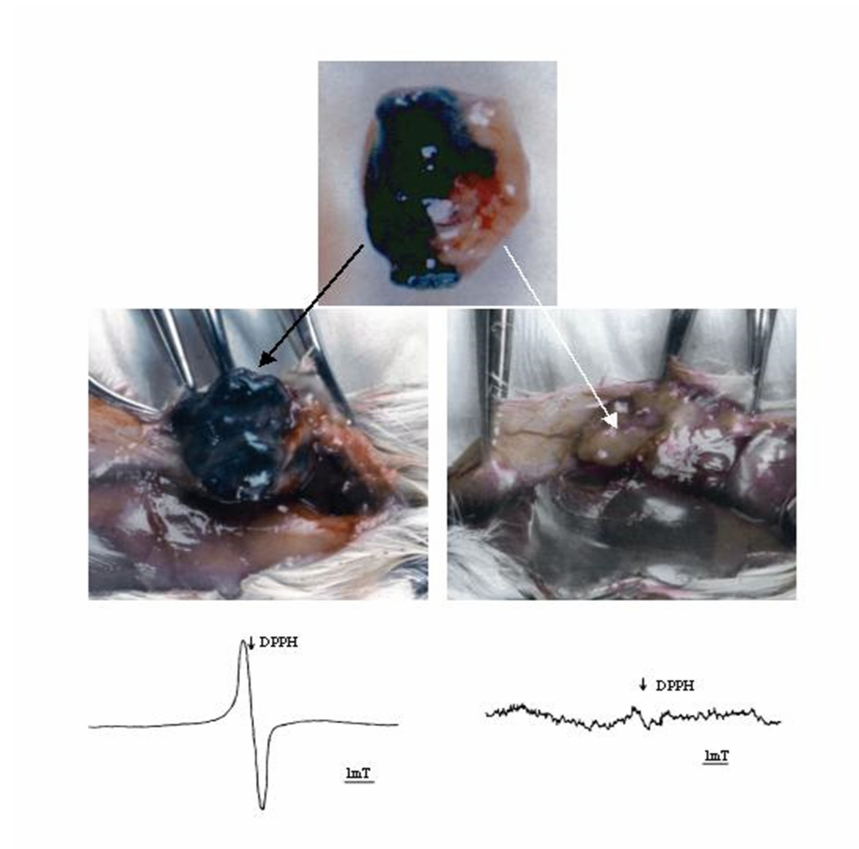
Figure 7. Electron paramagnetic resonance (EPR) analysis of melanotic ( left EPR spectrum) and amelanotic tumors ( right ) of Zeman UJ90 melanomas, corresponding to the black and white tumors (photographs in the middle row). The white tumor was obtained from the white parts of the two-color tumor which appeared in passage 7 (upper photograph). DPPH: the position of a free radical signal (g = 2.0037). Reprinted with permission from Copyright 2003 John Wiley & Sons Ltd.